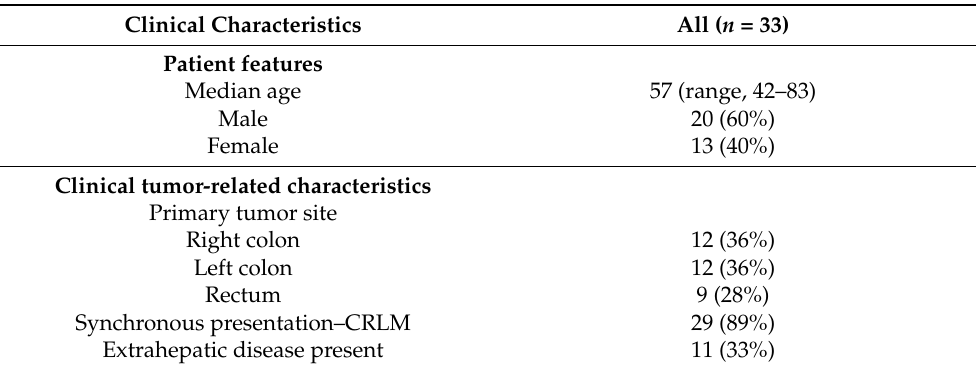
Table 1. Features of patients with colorectal liver metastasis, followed by partial liver resection after